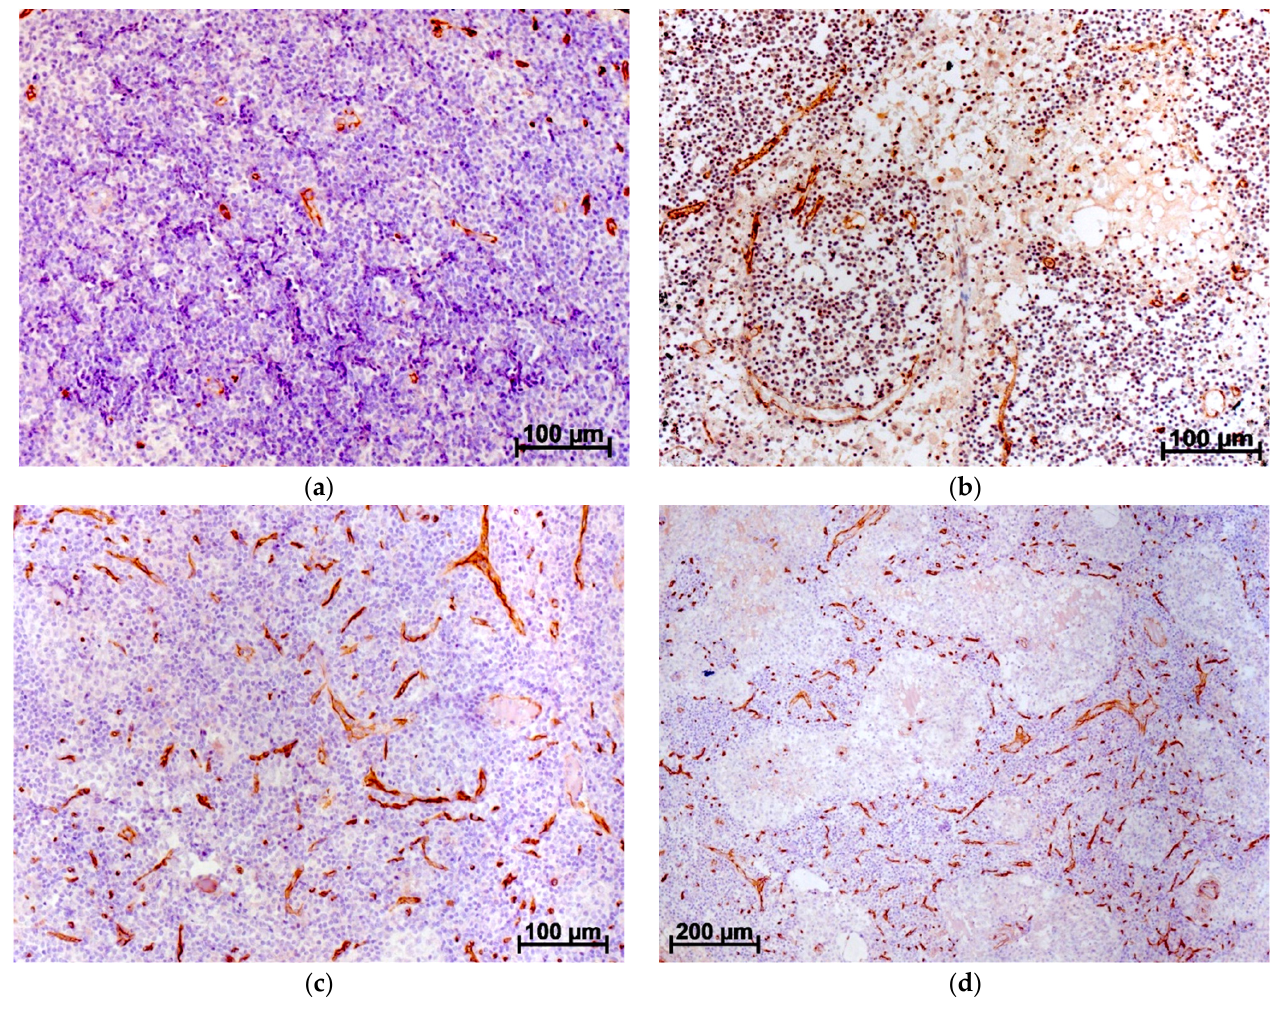
Figure 1. Human axillary LN. Immunohistochemical reaction with CD34 antibodies stained with diamidobenzidine and hematoxylin: ( a ) control LN, few CD34+ vessels in the superficial part of the cortex and paracortex, waste areas of the cortical substance free from CD34+ structures; ( b ) control LN, due to the postmortem changes, the medullary cords and sinuses lost well-defined structure, cell composition rare, single CD34+ vessels located at the edge of cords and sinuses, no CD34+ structures observed in the huge areas of the medullary substance; ( c ) LN at BC stage IIIa, small CD34+ vessels infiltrate practically the total cortical substance, walls of these vessels consist of one cell layer. ( d ) LN at BC stage IIIa, small CD34+ vessels infiltrate practically the total medullar substance of parenchyma [8,9].